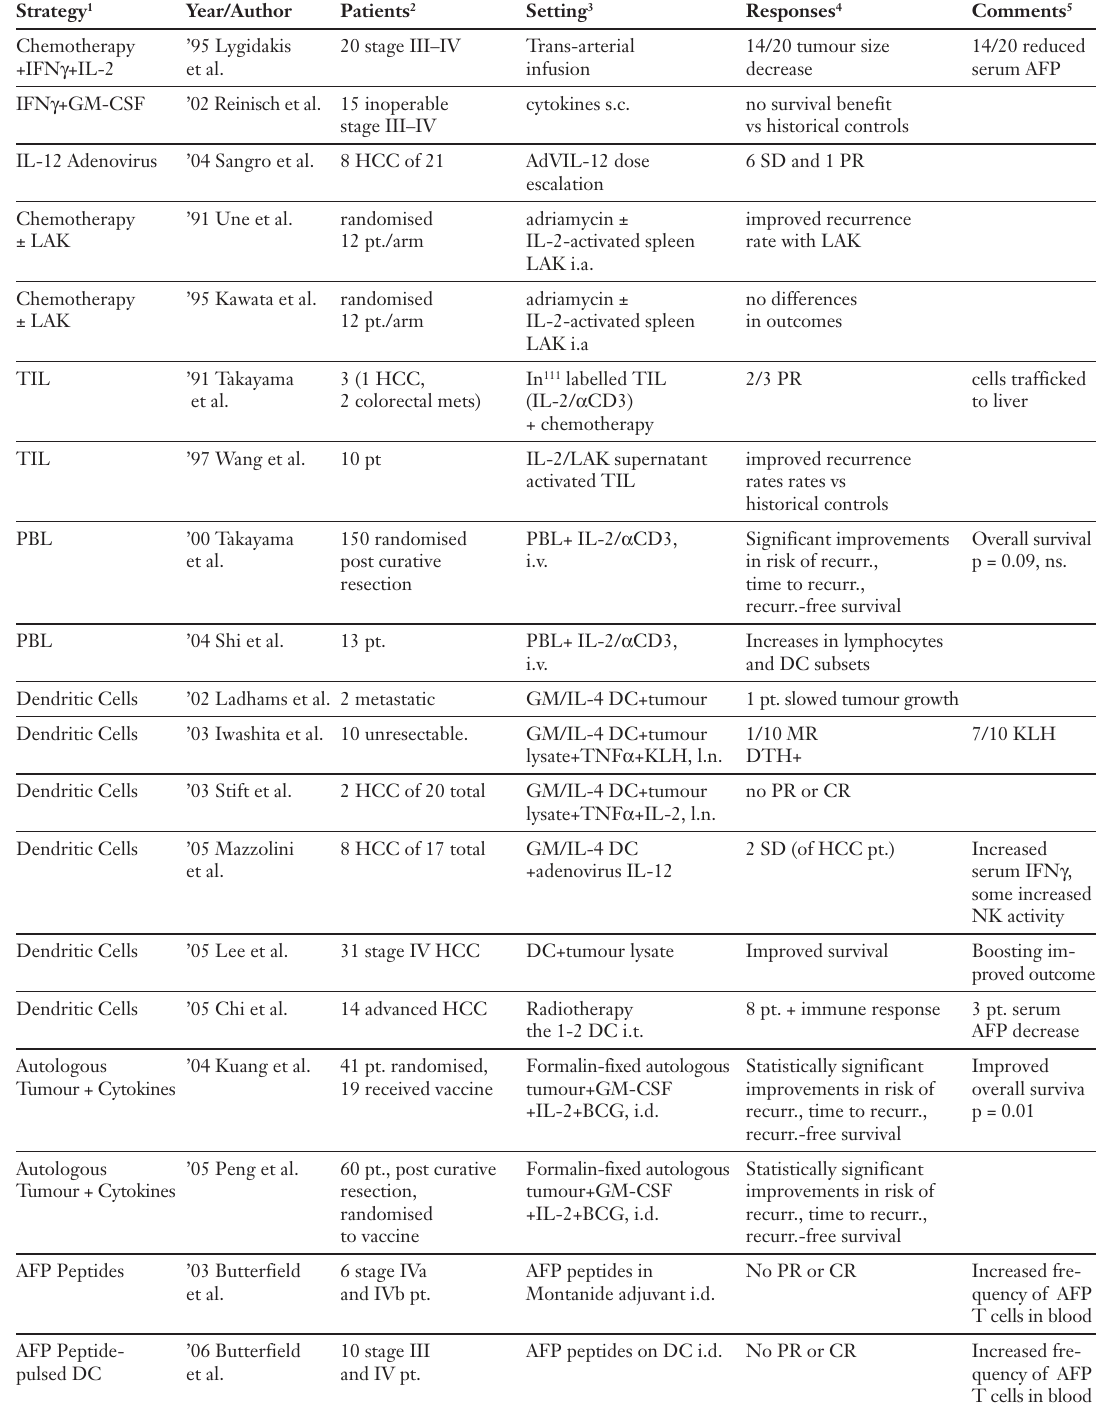
Immunotherapy clinical